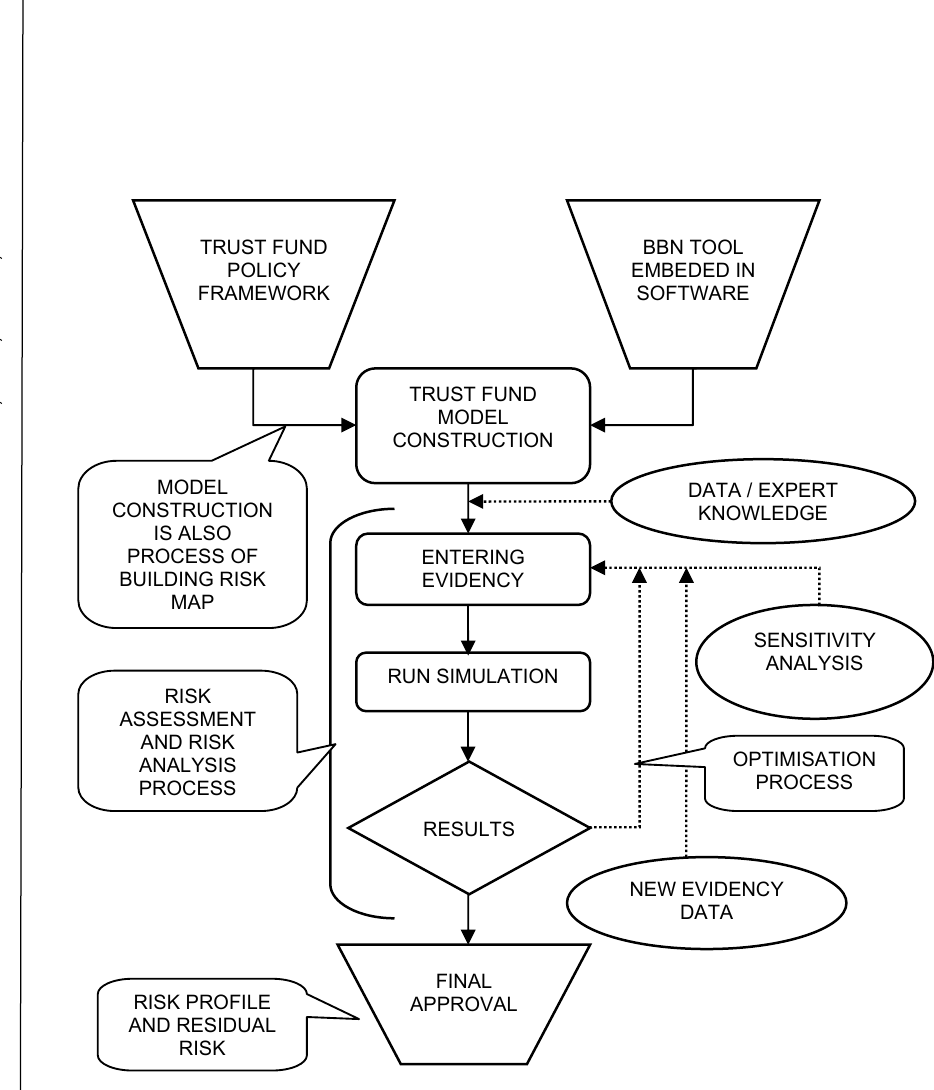
Diagram 1 – Framework for the risk assessment process using a BBN and the AgenaRisk